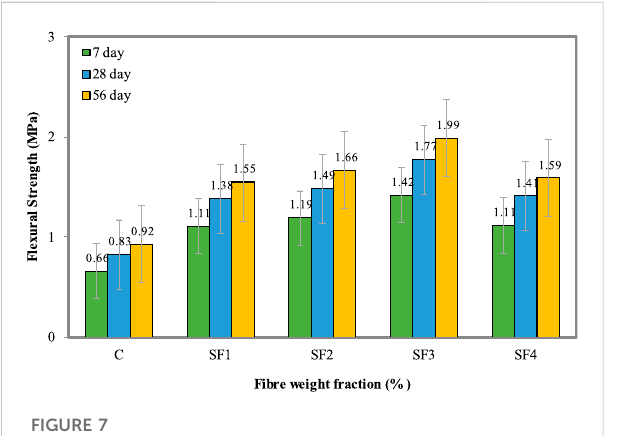
FIGURE 10 Tensile strength of 1,000 kg/m 3 FC density with varying weight fractions of SF.